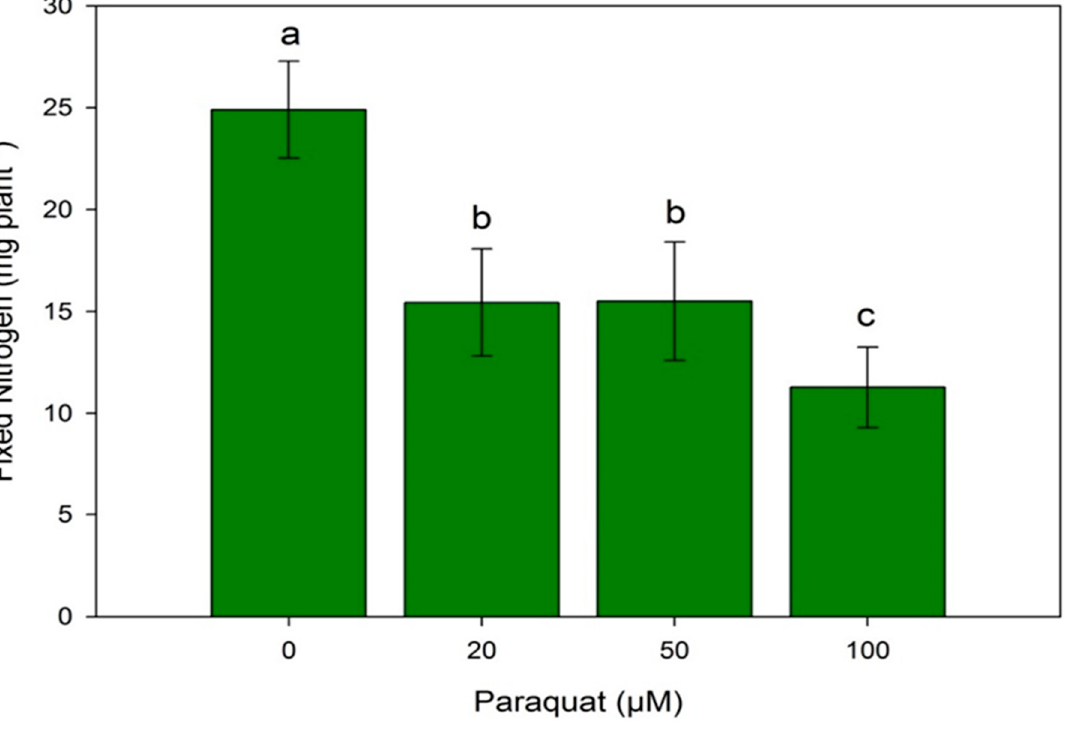
Figure 3. Effect of paraquat addition on fixed nitrogen (FN) by soybean plants inoculated with B. diazoefficiens 110 spc 4. Similar letters are not statistically different according to the Wilcoxon–Mann–Whitney test ( p ≤